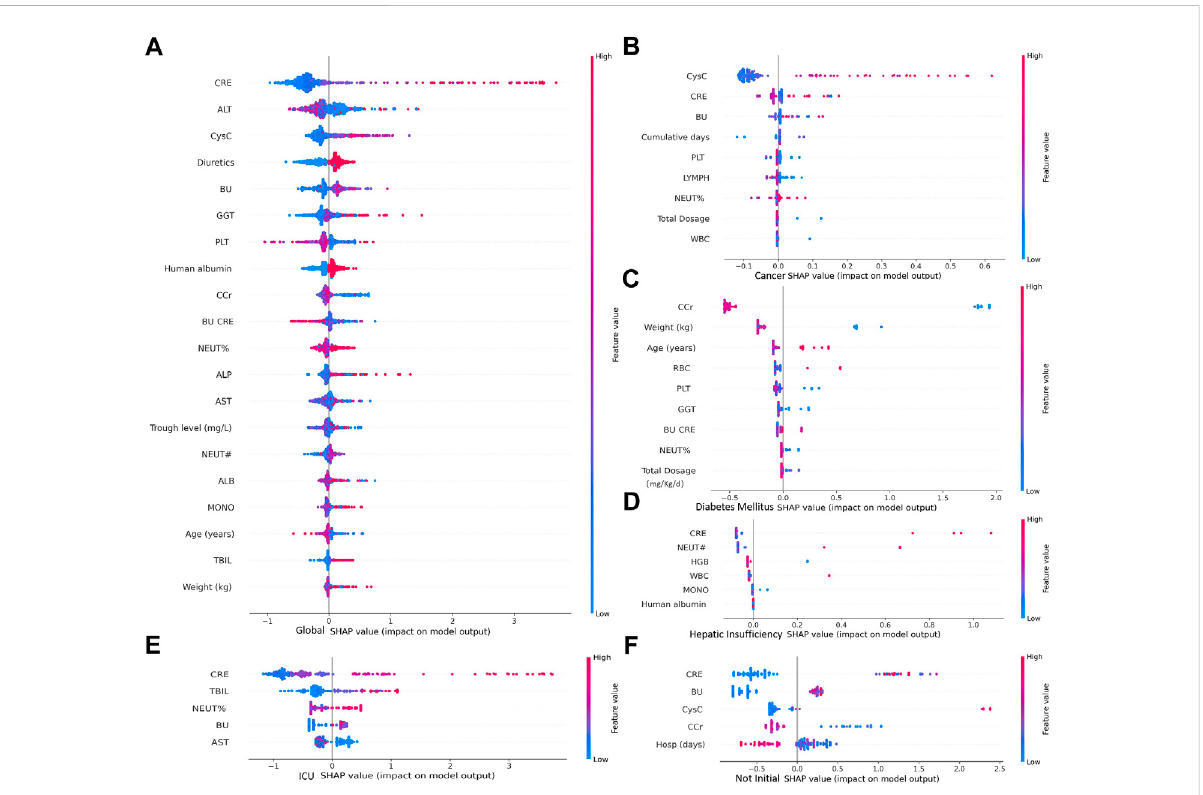
FIGURE 5 Importance of clinical variables for different underlying diseases. In a bee swarm plot, each point corresponding to a sample of data set. The position of each point on the horizontal axis indicated the effect of that feature on the model prediction, and the color of a point re fl ected the eigenvalueofthecase. Variableswereranked indescendingorderof importance intermsoftheir impacton themodel predictions, with thevariable on top being the most